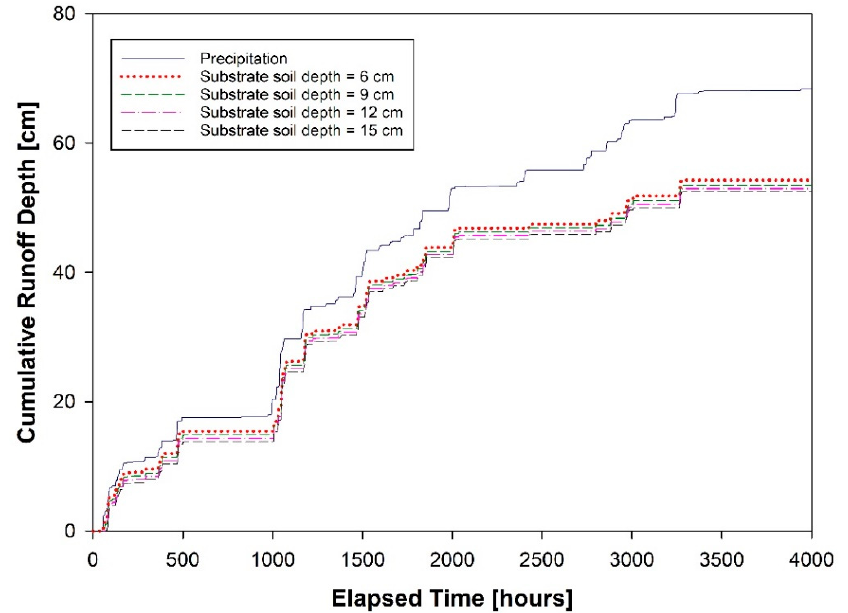
Figure 5. Cumulative rainfall and cumulative modeled runoff for different values of soil depth (H) by considering a six-month dataset (January–June 2016).